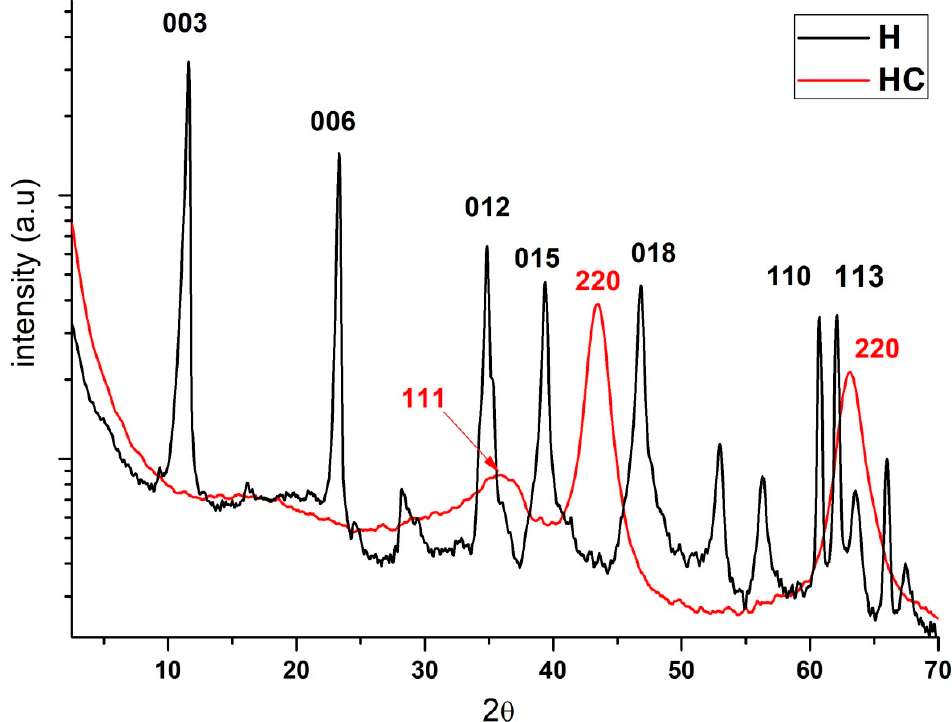
Figure 2. Diffraction patterns of the hydrotalcite without calcining (H), the hydrotalcite after the calcination at 600 °C for 4 h.